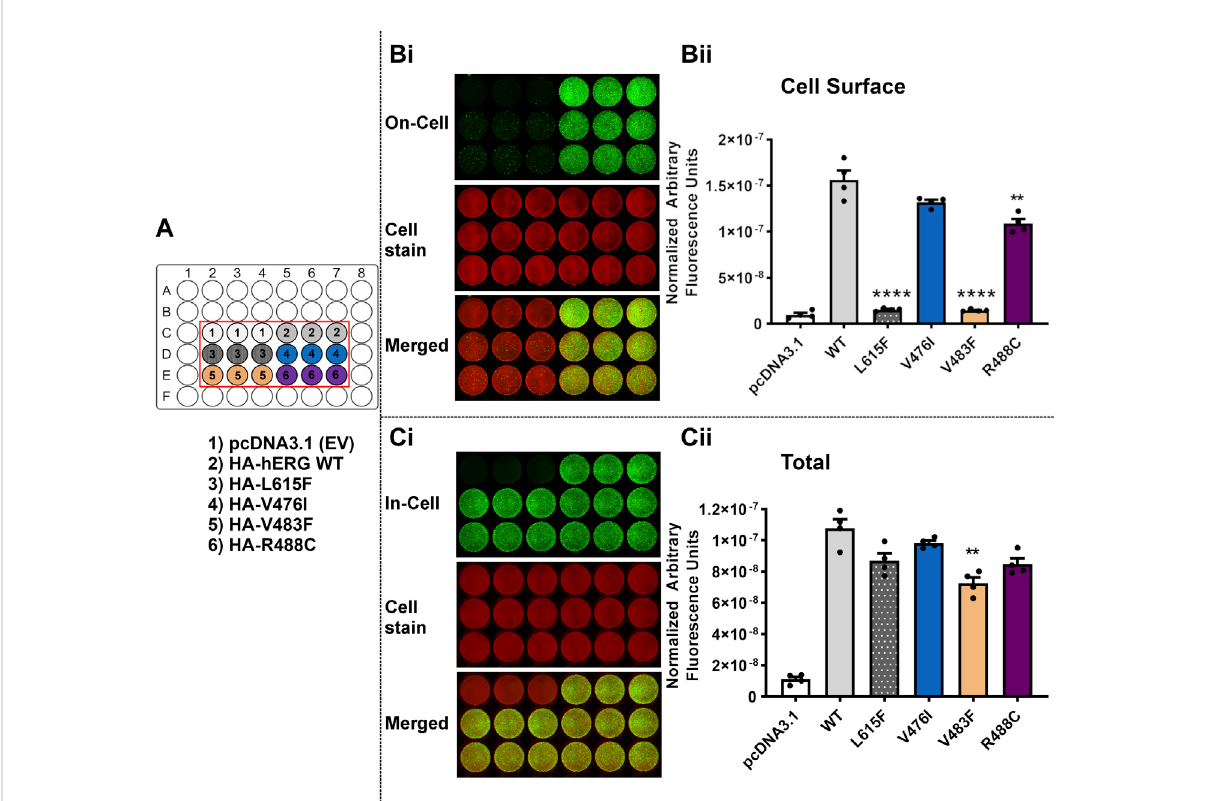
FIGURE 7 VariantV483F, butnotV476IandR488C, severelyperturbstraf fi ckingofthehERGchannel.Traf fi cking assayforthreehERGVSDvariantsV476I, V483F and R488C with WT hERG and control (L615F). A detailed description of thepanels can befound in thelegend toFigure 5. Data are presented as (mean ± SEM) from four independent repeats [individual data points are displayed in (Bii,Cii) ]. Statistical analyses were performed using one way